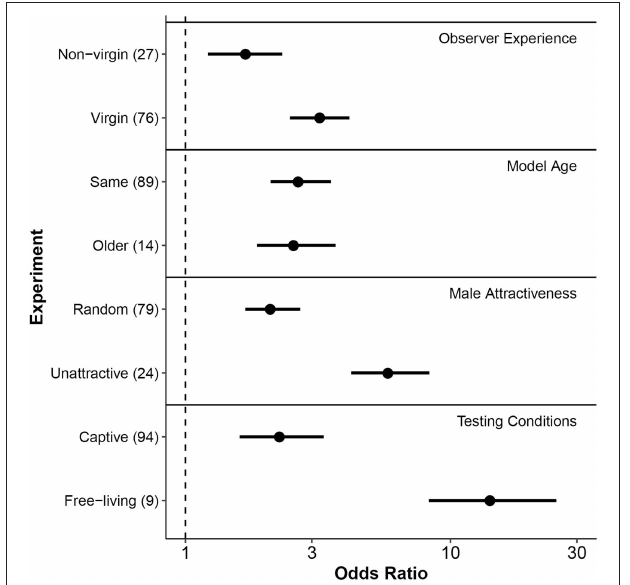
FIGURE 3 | Forest plot of posterior mean effect sizes (odds ratios) of each moderator level hypothesized to affect mate-choice copying. Horizontal lines associated with points indicate 95% credible intervals of the mean odds ratio. Levels of each fixed effect (y-axis) are grouped by moderator type, shown at right. Numbers in parentheses following each level indicate the number of effect sizes included from experiments that met those conditions. The dashed vertical line indicates an odds ratio of 1, equivalent to a 50/50 likelihood of mating with a male after observing another female choose that male, or a phenotypically similar individual. X-axis is on a log10 scale. Model female age refers to the model’s age relative to the observer female. In many cases, differences noted referred to relative size rather than age per se , as size is a commonly used proxy of age in fish with indeterminate growth.